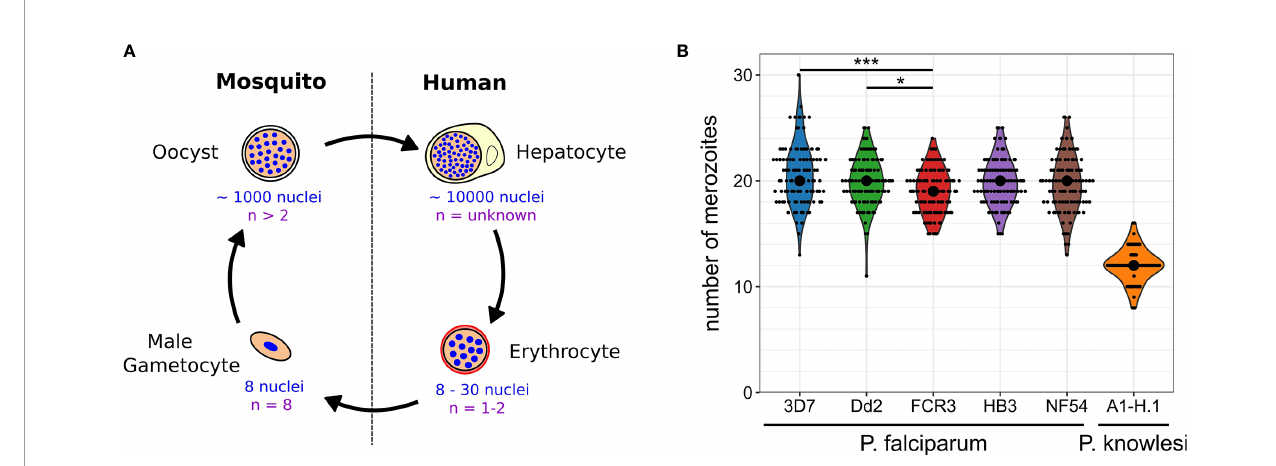
FIGURE 1 | Nuclear and genome copy numbers throughout Plasmodium spp. life cycle stages. (A) Schematic depiction of approximate total number of nuclei produced during the proliferative life cycle stages of P. falciparum as well as the highest observed ploidy (n) or genome copy number within individual nuclei. (B) Number of merozoites produced in P. falciparum and P. knowlesi . To count merozoites, late stage parasites were enriched by magnetic puri fi cation or Nycodenz density gradient. Parasites were incubated with the cyclic GMP-dependent protein kinase (PKG) inhibitor ML10 (25 nM in P. falciparum strains; 125 nM in P. knowlesi ) for 3 h to prevent egress, increasing the percentage of post-mitotic parasites. After preparation of blood smears parasites were fi xed with 4% paraformaldehyde for 20 min at 37°C. Before imaging, cells were stained with Hoechst. Microscopy was performed on a Leica TCS SP8 scanning confocal microscope with Lightning (LNG) module. LNG enables automated adaptive deconvolution after acquisition resulting in super-resolution images. For each Plasmodium strain, 100 cells were imaged. Merozoites were counted in a single-blind mode by three independent researchers using Fiji. The mean merozoite number for each individual cell was taken to create the violin plot. The centered black dot represents the median. High density of nuclei in P. falciparum made it dif fi cult to assess the de fi nitive fi nal number of nuclei. This counting error might contribute to the presence of many uneven numbers in P. falciparum strains, while in P. knowlesi almost exclusively even numbers were counted. For statistical analysis, a Welch-ANOVA test was performed, and individual lines were compared with a post hoc Games-Howell test using R studio. For P. falciparum strains, FCR3 and 3D7 (p = 2.4x10^-4) as well as FCR3 and Dd2 (p = 4.2x10^-2) showed signi fi cant